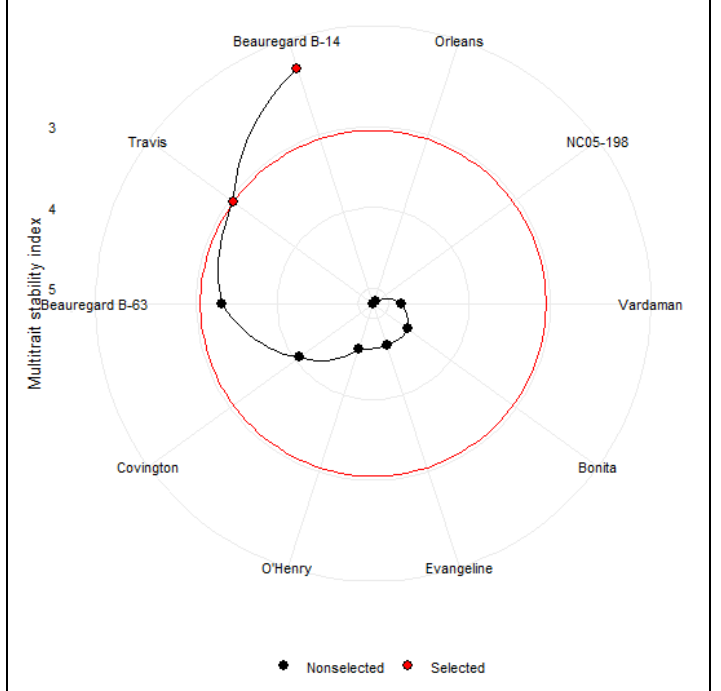
Figure 6. Genotype raking of cultivars based on the multitrait stability index of ten sweetpotato cultivars evaluated under drought, low-nitrogen, ultraviolet-B, and control treatments. The selected genotypes based on this index are shown in red, and the central red circle represents the cutpoint according to the selection intensity (20%).